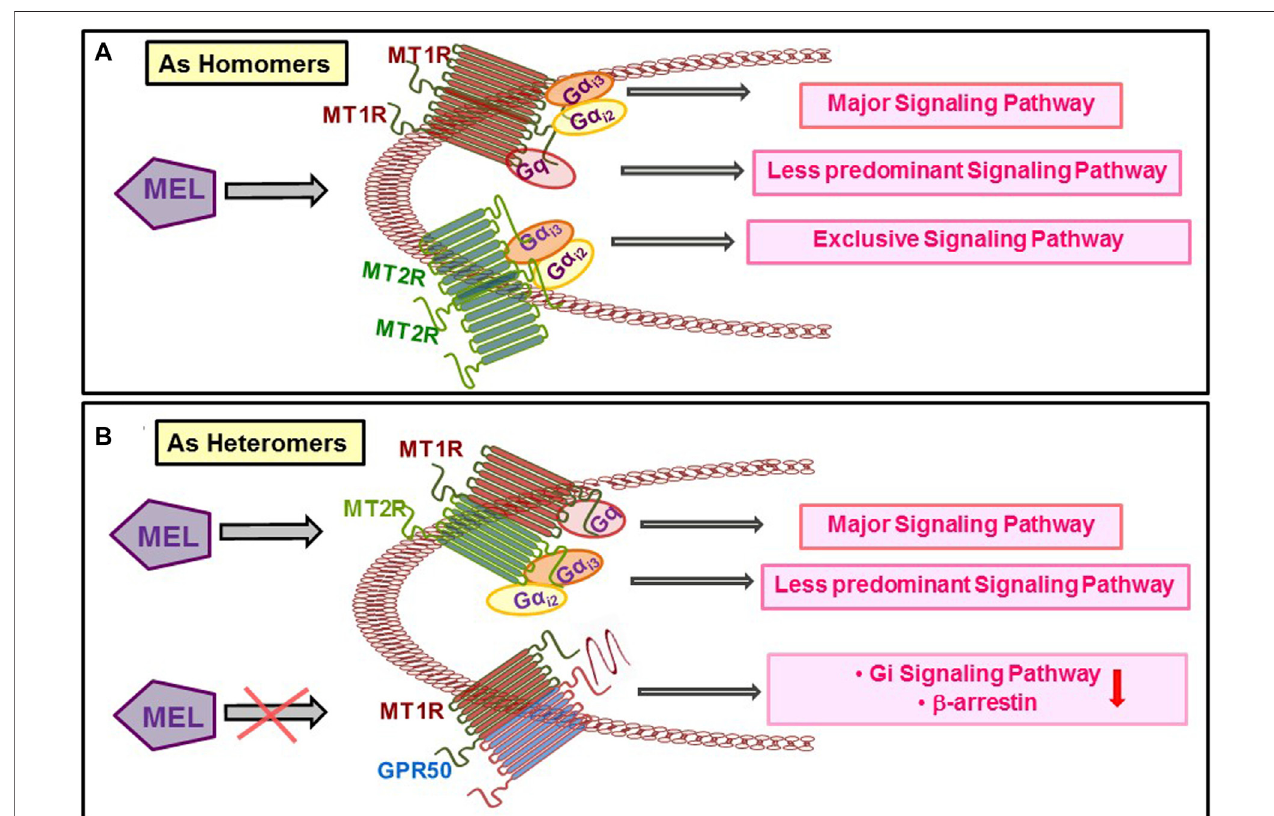
FIGURE 2 | Dimerization of the different types of Mel receptors regulates the preference for G protein binding and signalling.